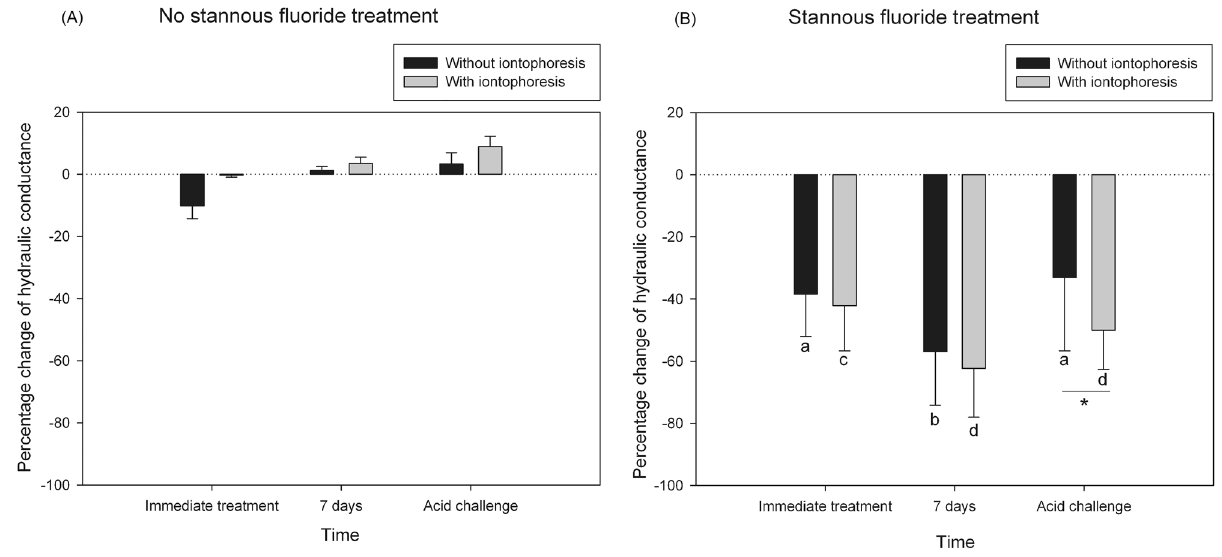
Figure 1. Mean (± 1 SD) percentage decreases of hydraulic conductance of dentin after ( A ) no stannous fluoride treatment; ( B ) stannous fluoride treatment, without (black column) and with (gray column) iontophoresis at immediate treatment, 7 days and acid challenge. The same lowercase letter represents no significant change among the times of treatment. *Statistically significant difference between without and with iontophoresis ( p < 0.05, 2-way repeated measures ANOVA and Tukey